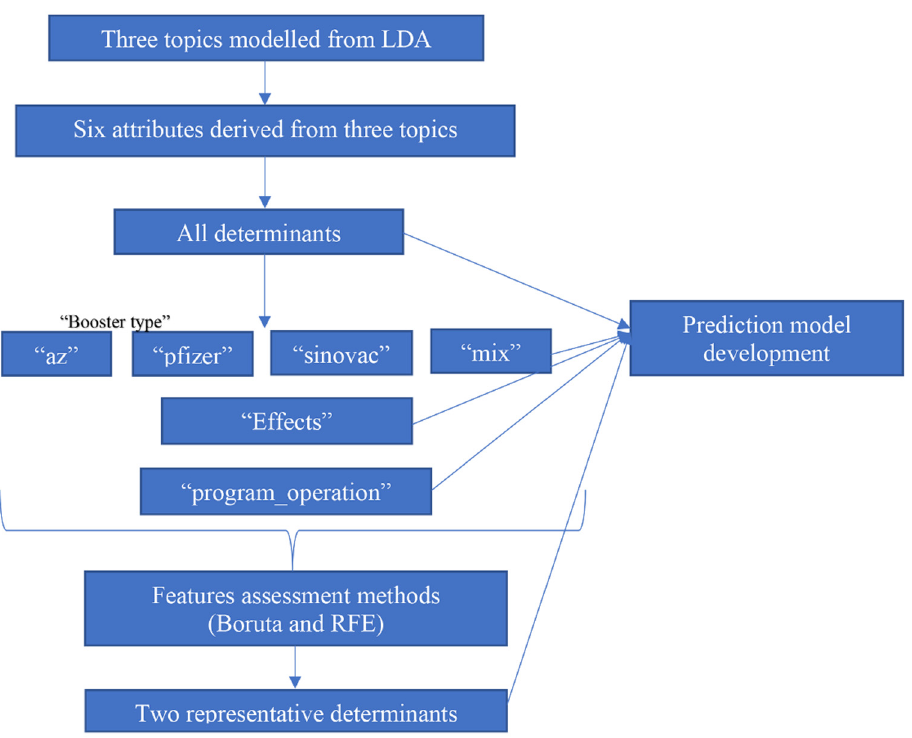
Figure 10. Feature assessment process and numbers of features obtained from each method.